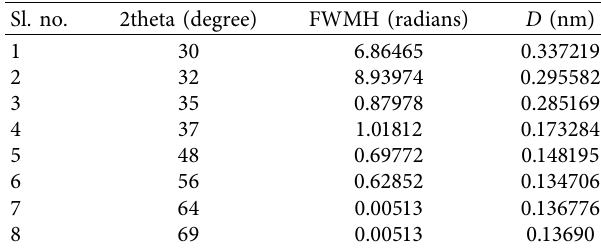
Figure 2: X-ray diffraction pattern of (a) biosynthesized magne- sium oxide (MgO) from Datura stramonium leaves extract and (b) chemosynthesized nanoparticles. Table 1: XRD data and calculation of peaks parameters: 2theta, FWMH, and crystalline size